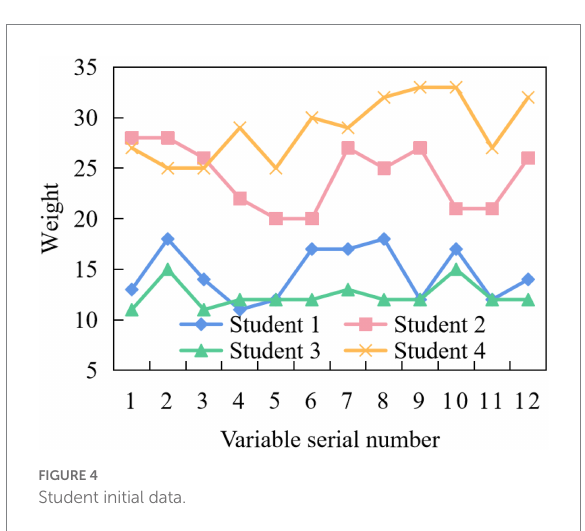
FIGURE 4 Student initial